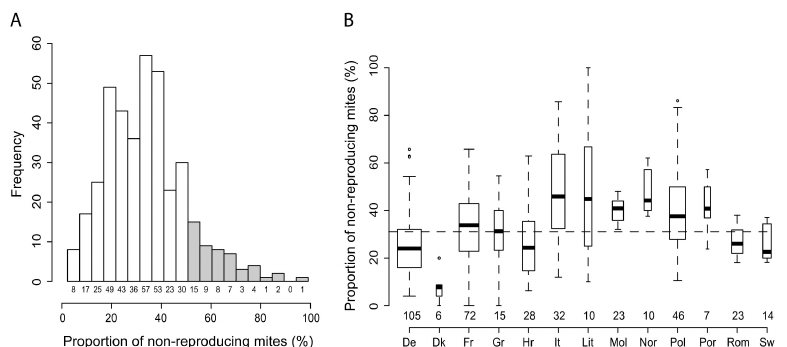
Figure 2. Distribution of the suppression of mite reproduction (SMR) score within Europe. ( A ) Histogram of distribution of the total data and ( B ) SMR scores by country for each of the 13 sampled countries. Grey histogram bars indicate colonies with a varroa-resistance potential (SMR score ≥ 50%). Boxplot widths are proportional to the sample size which is indicated below each bar or plot. The dashed line represents the average SMR score among the sampled European countries. ◦ Indicate data points distributed outside 1.5 interquartile